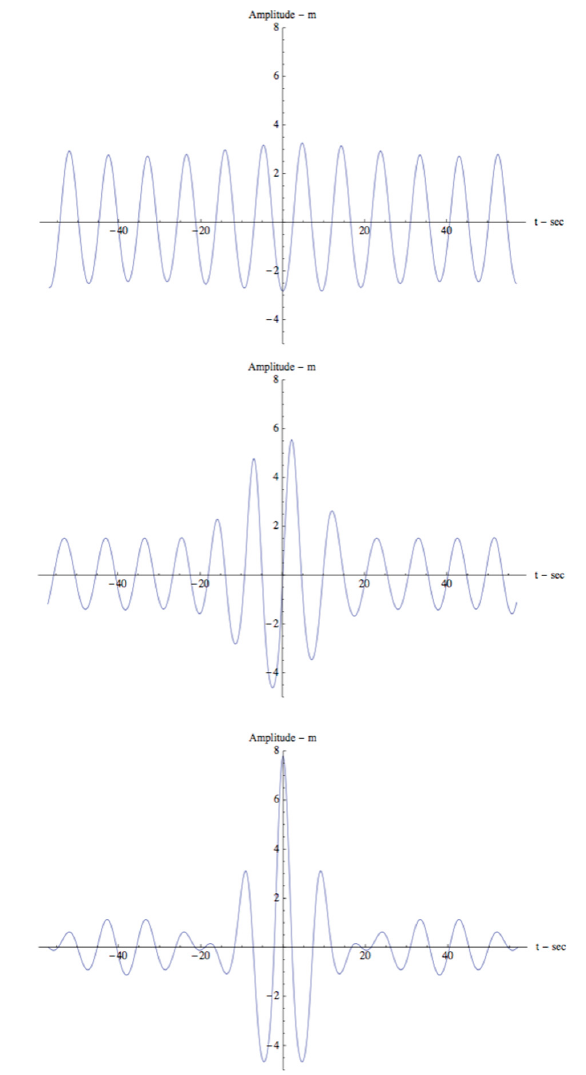
Figure 2. Evolution of a breather packet, or nonlinear beat. A small amplitude modulation of a 3 m sine wave (upper panel) evolves over two kilometers to form a well ‐ defined wave packet (central panel). After a total of four kilometers the wave train evolves into a robust, localized wave packet with a maximum amplitude of 8 meters (lower panel). The evolution from a low amplitude sine wave to a large amplitude packet is due to the Benjamin–Feir instability. This maximal state generates a central wave that is 8/3 = 2.67 times the initial amplitude. This behavior has tempted many investigators to refer to the central wave as a “rogue wave.” After the full localization of the wave packet in the lower panel, one finds that the packet then begins decreasing in amplitude once again and returns to the initial state in the upper panel, in exact reverse order. Such a dynamical motion is one “breath” of the nonlinear “dynamical breathing” of the modulational instability and constitutes a “breather cycle time.” See Osborne et al. [5] for more details.